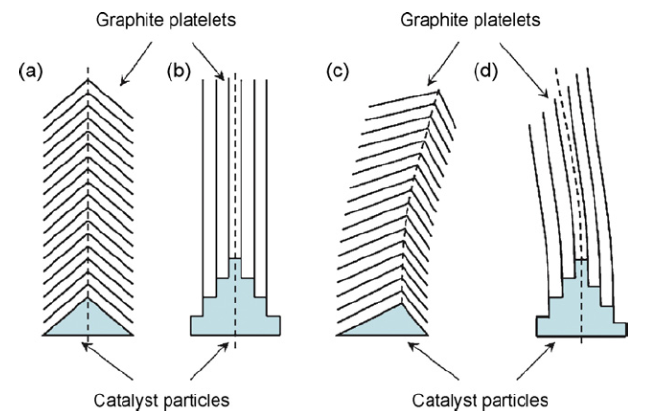
Figure 15. Schematics of growth of filaments from symmetric catalysts ( a , b ) and asymmetric catalysts ( c , d ) [49]. Reprinted with permission from [49], Copyright 2010 Elsevier.